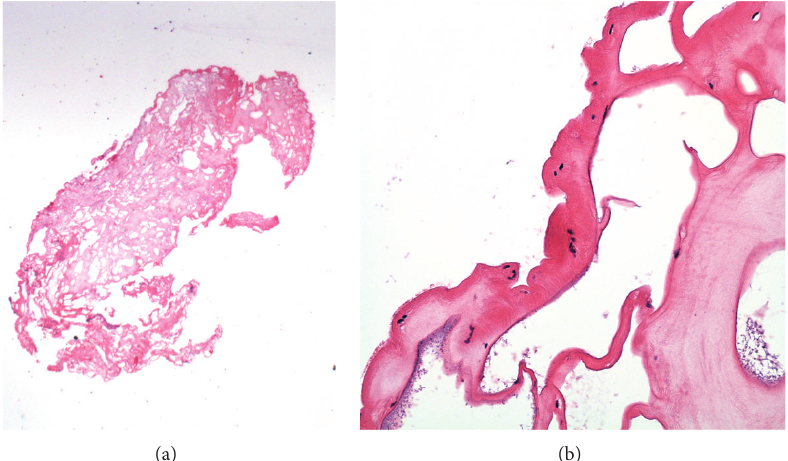
Figure 2: H&E stained sections demonstrating the degenerate parasite after initial craniotomy. (a) The entire tissue is a complex of cysts, with no viable basophilic nuclei apparent at low power, including no inflammatory cells (original magnification 12.5x). (b) At higher magnification, the edge of the abnormal tissue has the typical appearance of a chitinous exoskeleton with a few surviving small nuclei beneath it (original magnification